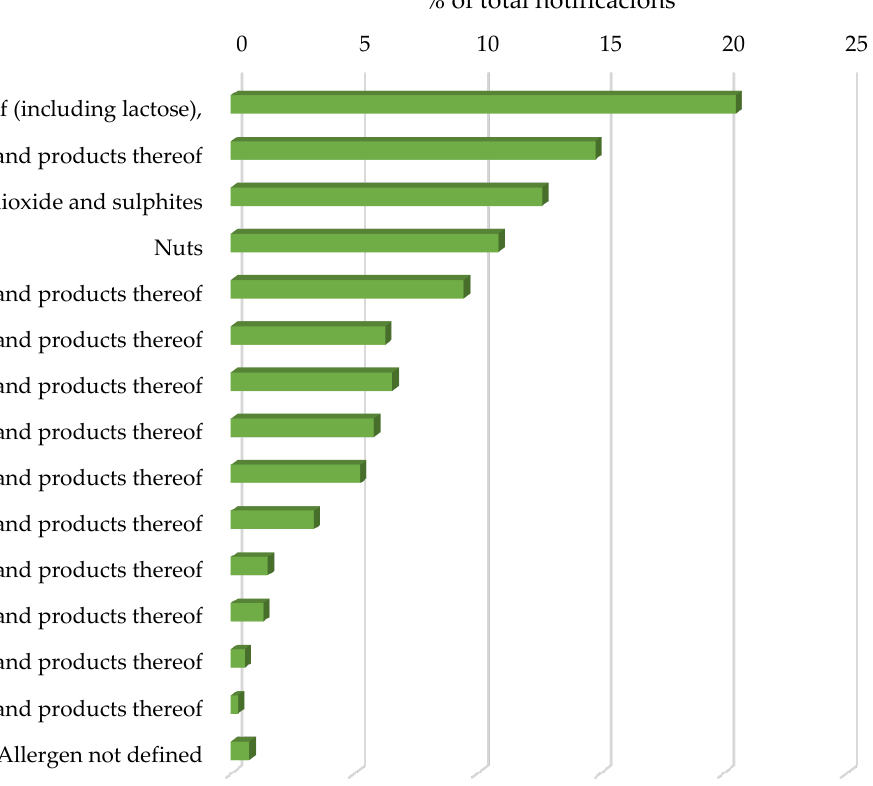
Figure 1. Percentage of actions taken as responses to notifications received between 1 January 2018 and 31 December 2021.